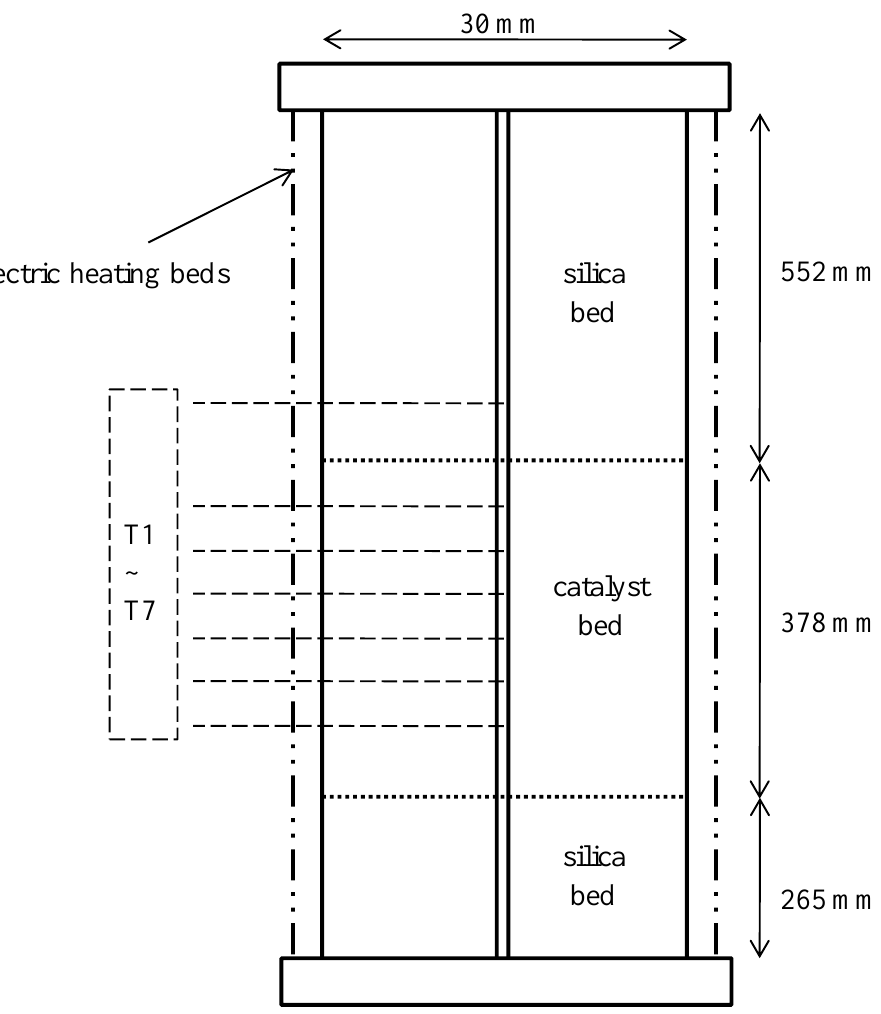
Figure 4. Scheme of the fixed-bed reactor. Table 1. Reactor specifications.